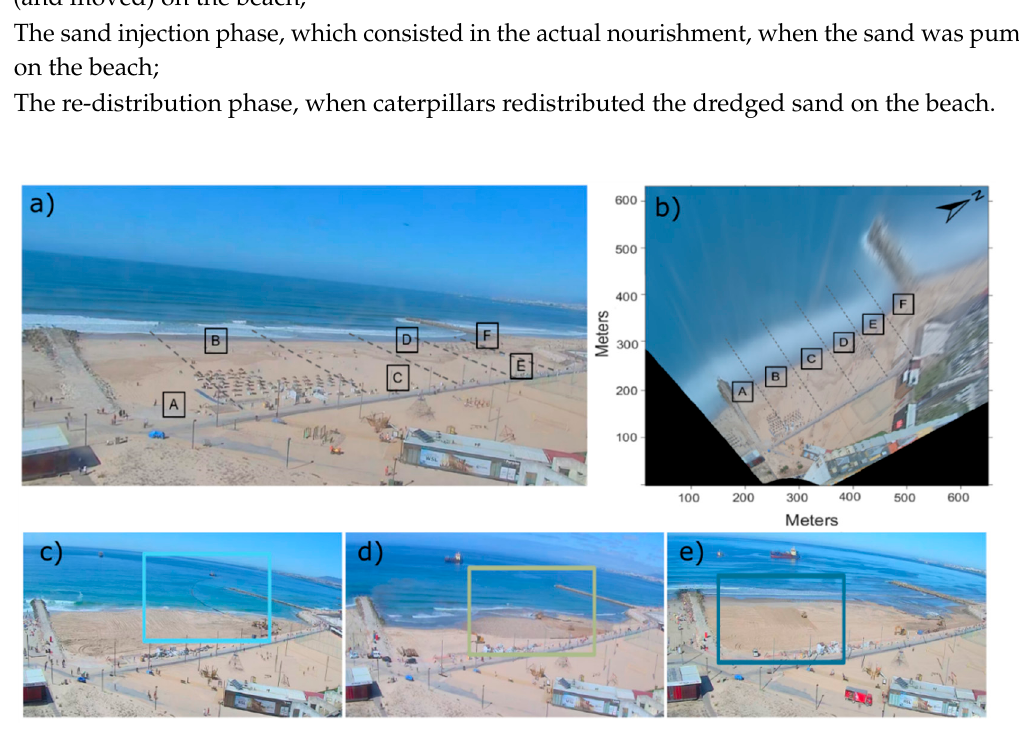
Figure 2. Different nourishment zones and nourishment phases at the Tarquínio-Paraíso beach. ( a ) Nourishment zones; ( b ) nourishment zones displayed on rectified image; ( c ) pipe-laying phase; ( d ) sand injection phase; and ( e ) re-distribution phase. The different rectangles indicate the specific area at the beach where each phase is taking